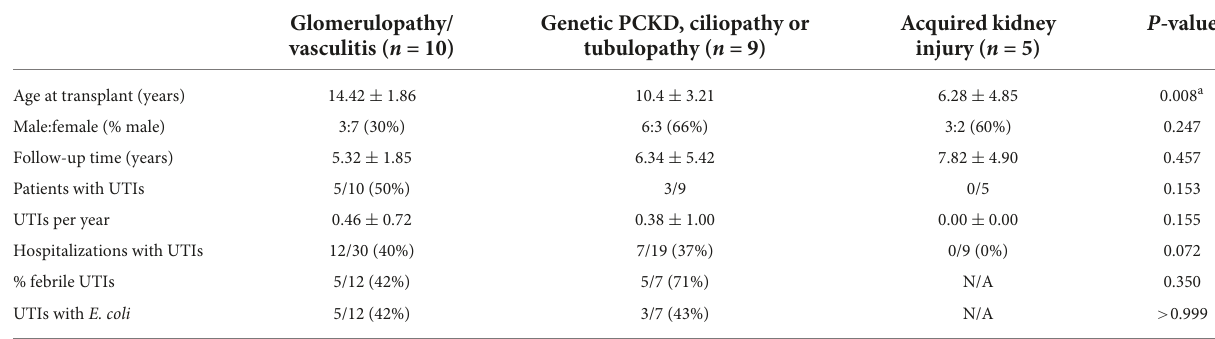
TABLE 4 Non-congenital anomalies of the kidney and urinary tract (CAKUT) group sub-analysis: urinary tract infection (UTI) rates and characteristics. Glomerulopathy/ Genetic PCKD, ciliopathy or vasculitis ( n = 10) tubulopathy ( n = 9)